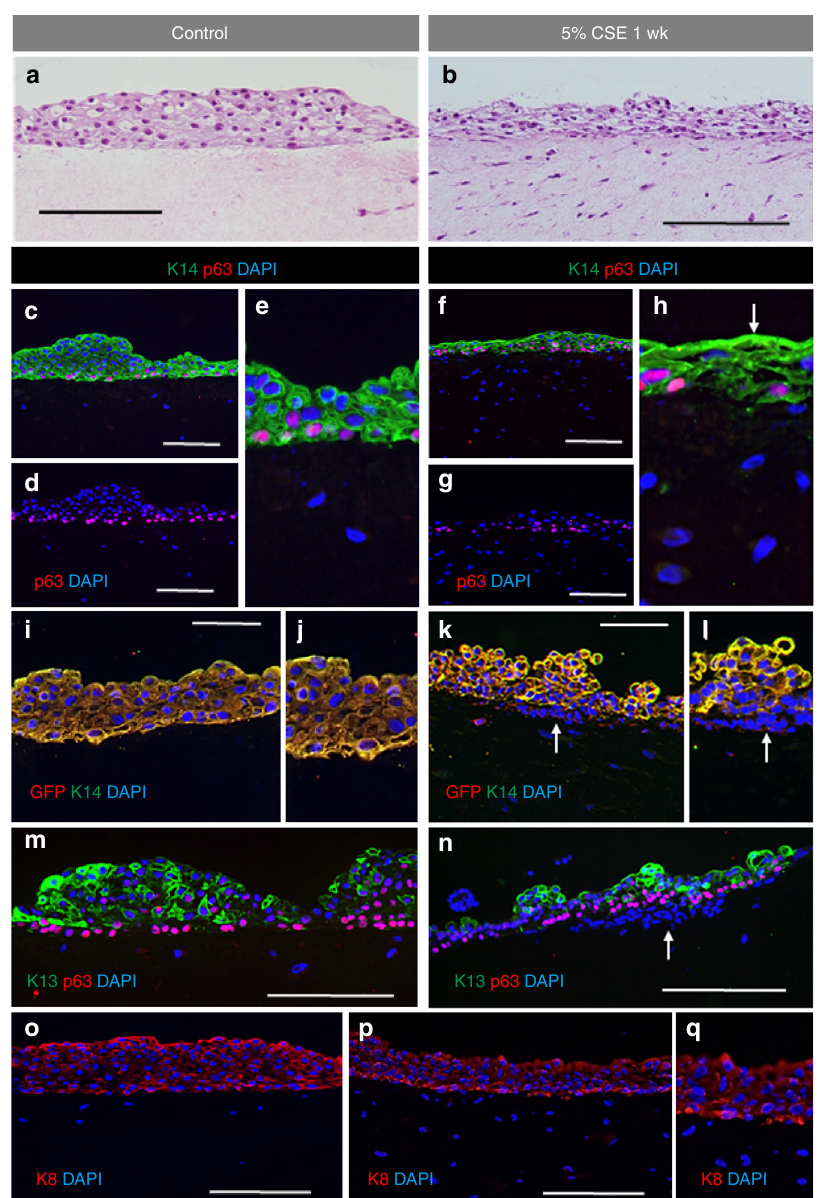
Fig. 8 Changes in expression of strati fi ed markers after 5% CSE exposure for 1 week. a , b Hematoxylin – eosin staining showing morphology of the control VF epithelium ( a ) and 5% cigarette smoke extract exposed VF epithelium ( b ). c – h Double immuno fl uorescent staining showing the expression of Cytokeratin 14 (green) and p63 gene (red) in control VF mucosa ( c , e ) and CSE exposed VF mucosa ( f , h ) and anti-p63 staining showing the p63 + basal cells in control VF mucosa ( d ) and CSE exposed VF mucosa ( g ). i – l Double immuno fl uorescent staining showing the expression of Cytokeratin 14 (green) along with GFP (red) in control VF mucosa ( i , j ) and CSE treated VF mucosa ( k , l ). White solid arrows point to downregulation of Cytokeratin 14 in the basal cellular compartment. m , n Double immuno fl uorescent staining showing the expression of Cytokeratin 13 (green) and p63 gene (red) in control VF mucosa ( m ) and CSE exposed VF mucosa ( n ). o – q Immuno fl uorescent staining showing the pattern of expression of Cytokeratin 8 in control VF mucosa ( o ) and CSE exposed VF mucosa ( p , q ). Scale bars in the panels of a , b , c , d , f , g , m , n , o , and p = 200 μ m. Scale bars in the panels of i , k = 100 μ m. CSE cigarette smoke extract, wk